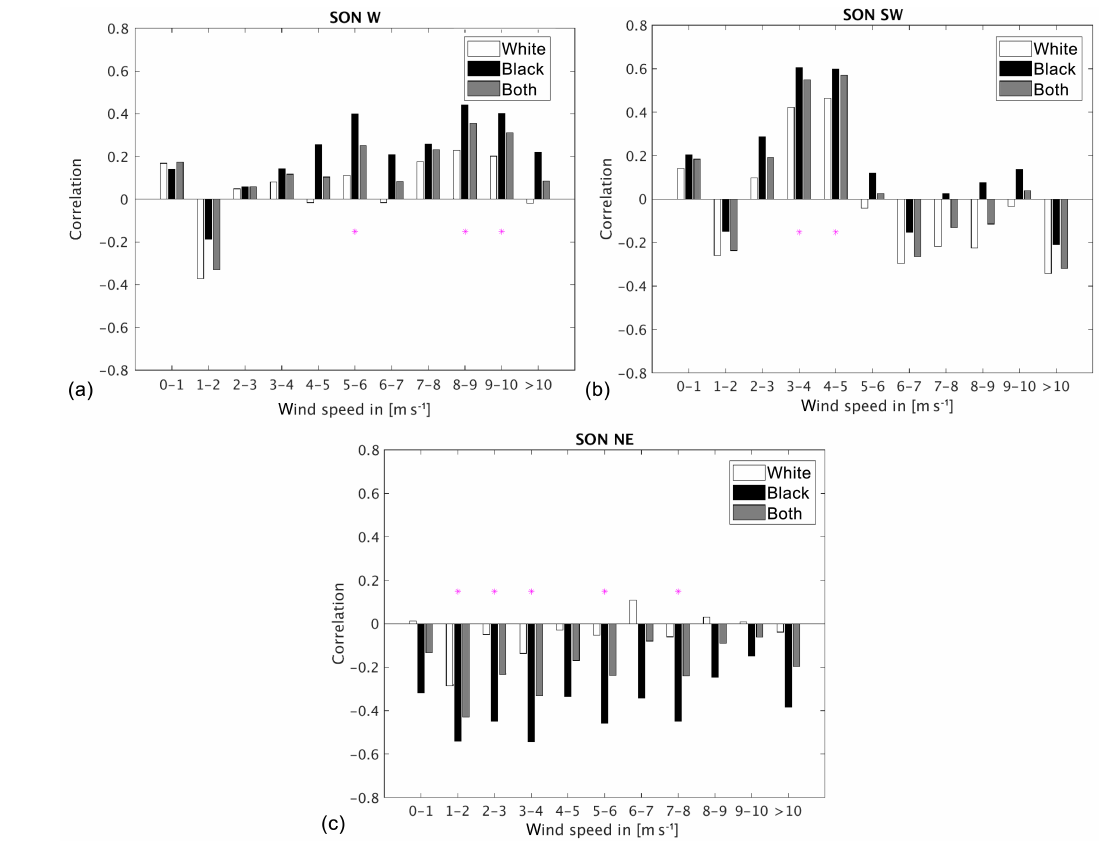
Figure 7. Correlation coefficients between the number of days per wind direction in a specified range of wind speeds and the dune thickness of the white layer (white), black layer (black), and both together (grey). The correlations are shown for autumn (SON) for the W (a) , SW (b) , and NE (c) wind directions. The correlations marked with * are significant at the 95% level.